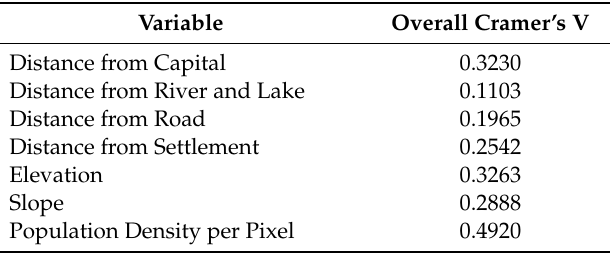
Table 5. Cramer’s V values of driving factors.